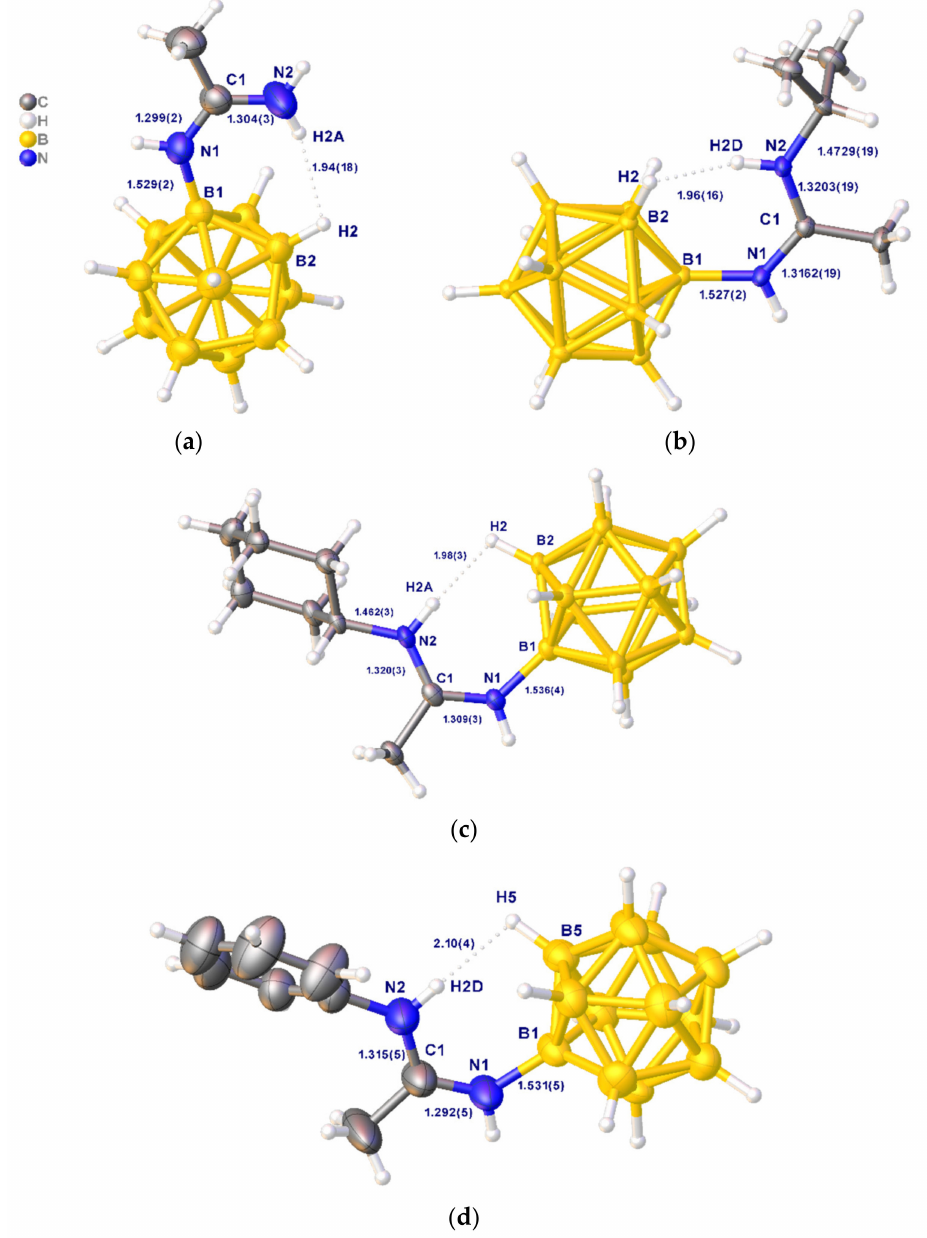
Figure 1. X-ray crystal structure of anions in the synthesized compounds ( a ) [B 12 H 11 NH=C(CH 3 )NH 2 ] − , ( b ) [B 12 H 11 NH=C(CH 3 )NH i C 3 H 7 ] − , ( c ) [B 12 H 11 NH=C(CH 3 )NHC 6 H 11 ] − and ( d ) [B 12 H 11 NH=C(CH 3 )NHC 6 H 5 ] −